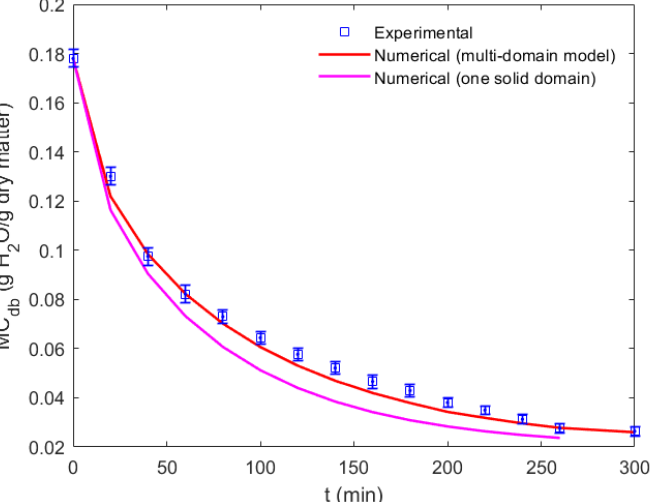
Figure 6. The moisture content dry basis versus the drying time. The quantitative comparison of the numerical results using one solid domain and a multidomain model (shell and core) with the experimental results under a constant temperature drying condition of 50 °C.